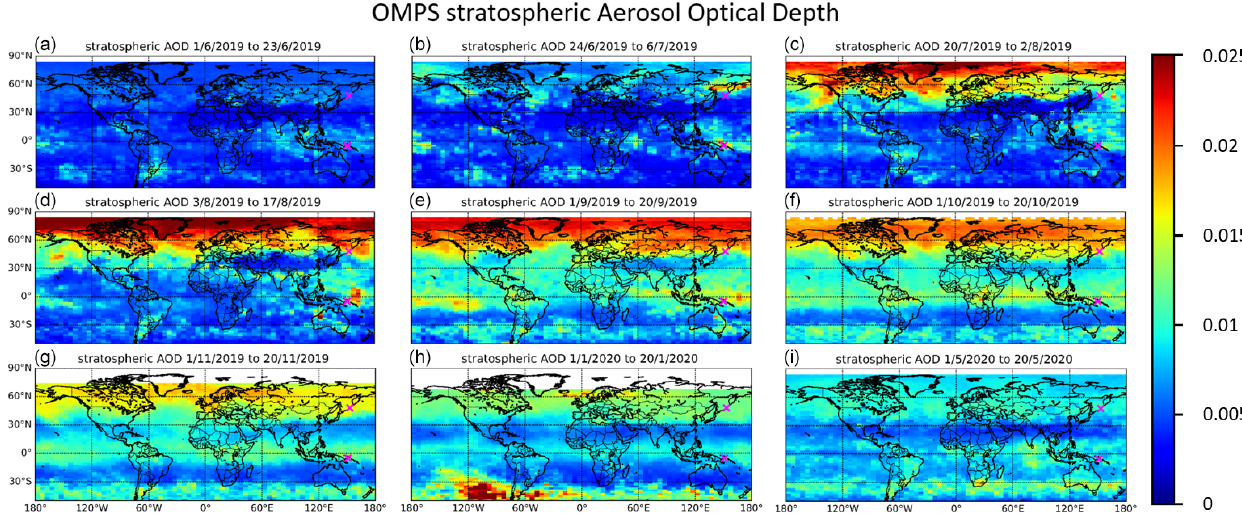
Figure 4. Global OMPS (at 675nm) sAOD averaged over the indicated time frames ( a–i : June 2019 to May 2020). The locations of Raikoke and Ulawun are indicated with magenta crosses. White areas in the north are not covered by OMPS